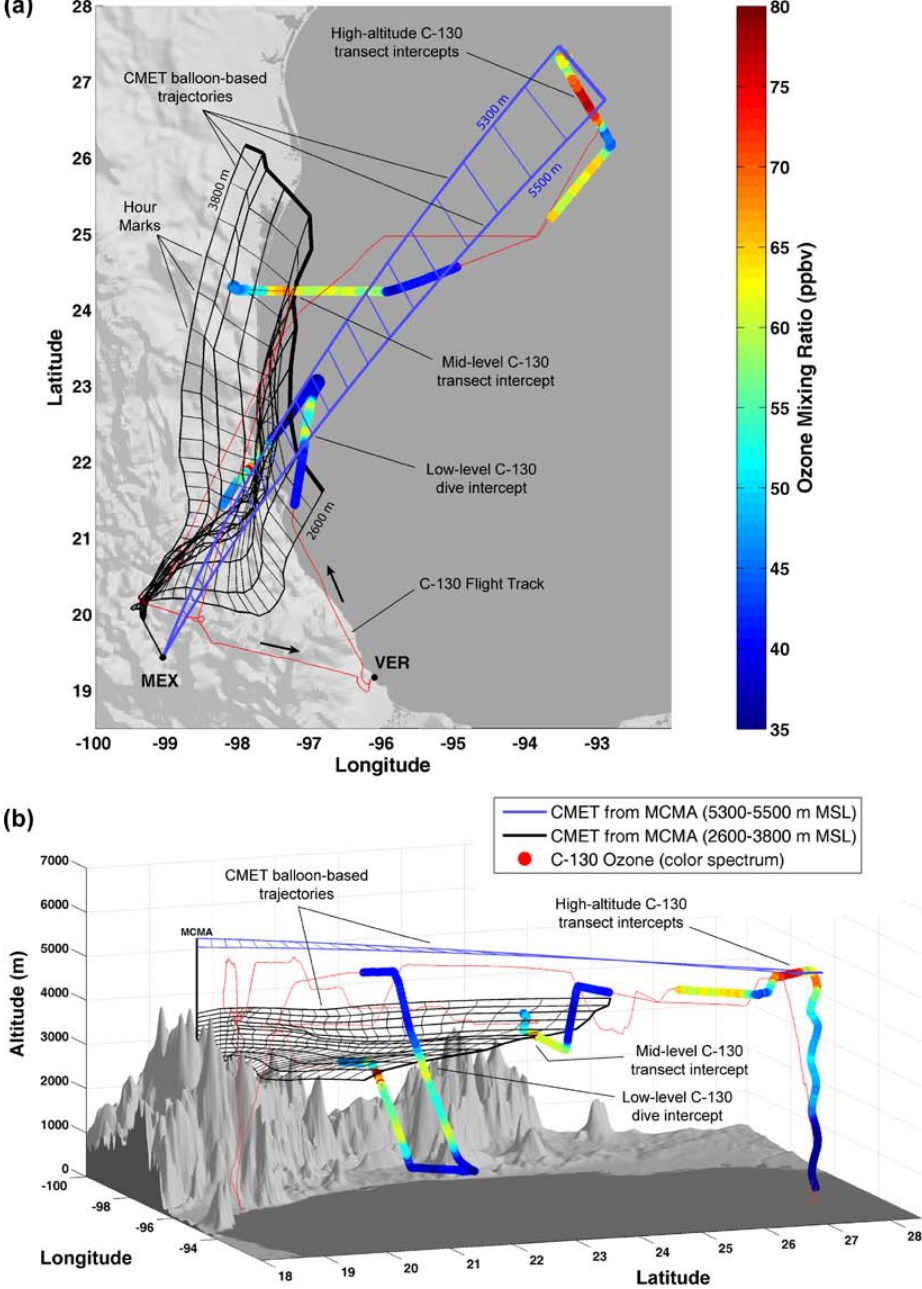
Fig. 12. Overview map (a) and three-dimensional plot (b) of the balloon-based trajectories originating from MCMA in the late afternoon of 18 March and continuing for 25h to the northeast. The trajectories were calculated directly from the CMET balloon winds and run at constant altitudes (100-m or 200-m intervals) with 1-h time intervals forming the mesh. The C-130 flight track on 19 March (thin red line) is highlighted by the observed O 3 mixing ratio (in color) where it approaches the outflow trajectories. From top to bottom in the figures, the intercepts are identified as the high-altitude transects, the mid-level transect, and the low-level dive. A fifth probable intercept (the low-level climb) can be seen under the black mesh to the left of the dive intercept. Ozone is used as an approximate urban tracer here because the CO instrument was briefly offline during one of the intercepts. The tracer observations made by the C-130 during the intercepts are described in detail in Sect.